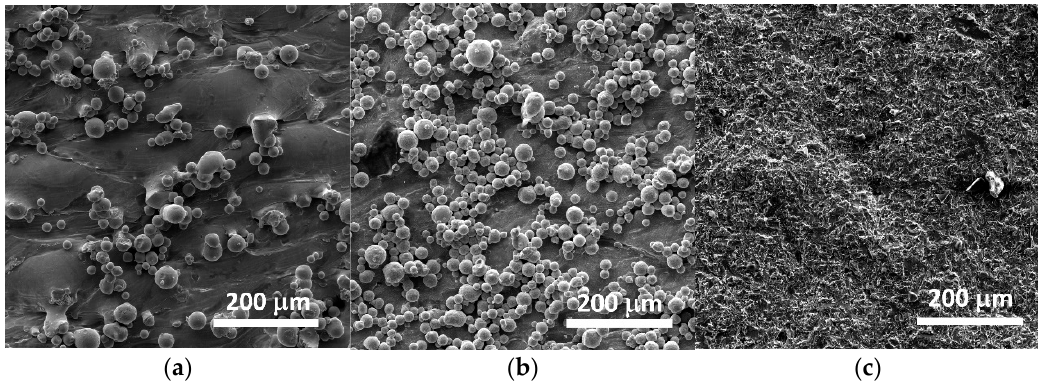
Figure 5. SEM images of the CL50WS specimen surface ( a ) Sample 4; ( b ) Sample 5 and ( c ) Sample 6.